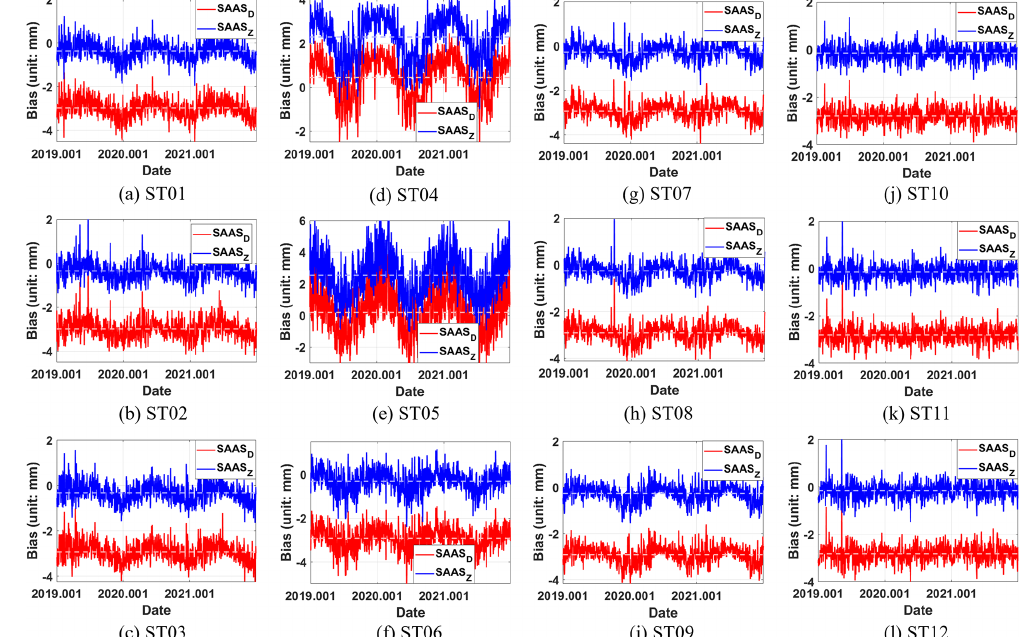
Figure 2. Bias time series of the model SAAS D and SAAS Z . Panels (a) – (l) represent the situations of the 12 sites, respectively. The light-red dotted line and light-blue dotted line show the mean value of bias series from SAAS D and SAAS Z , respectively. Table 1. Geodetic coordinates of study areas and corresponding climate types. Group Site Latitude Longitude Altitude Climate type abbreviation (unit: ◦ ) (unit: ◦ ) (unit: m) 1 ST01 36.83 − 89 . 17 94.9 Humid subtropical climate ST02 33.80 − 92 . 30 60.5 Humid subtropical climate ST03 35.33 − 88 . 83 136.1 Humid subtropical climate 2 ST04 − 30 . 50 − 69 . 50 3094.0 Cold desert climate ST05 − 30 . 67 − 68 . 67 1014.3 Hot desert climate ST06 − 30 . 50 − 62 . 00 94.0 Humid subtropical climate 3 ST07 38.50 − 36 . 33 0 – ST08 38.17 − 35 . 50 0 – ST09 39.17 − 41 . 83 0 – 4 ST10 − 27 . 83 75.17 0 – ST11 − 27 . 33 83.33 0 – ST12 − 28 . 50 82.83 0